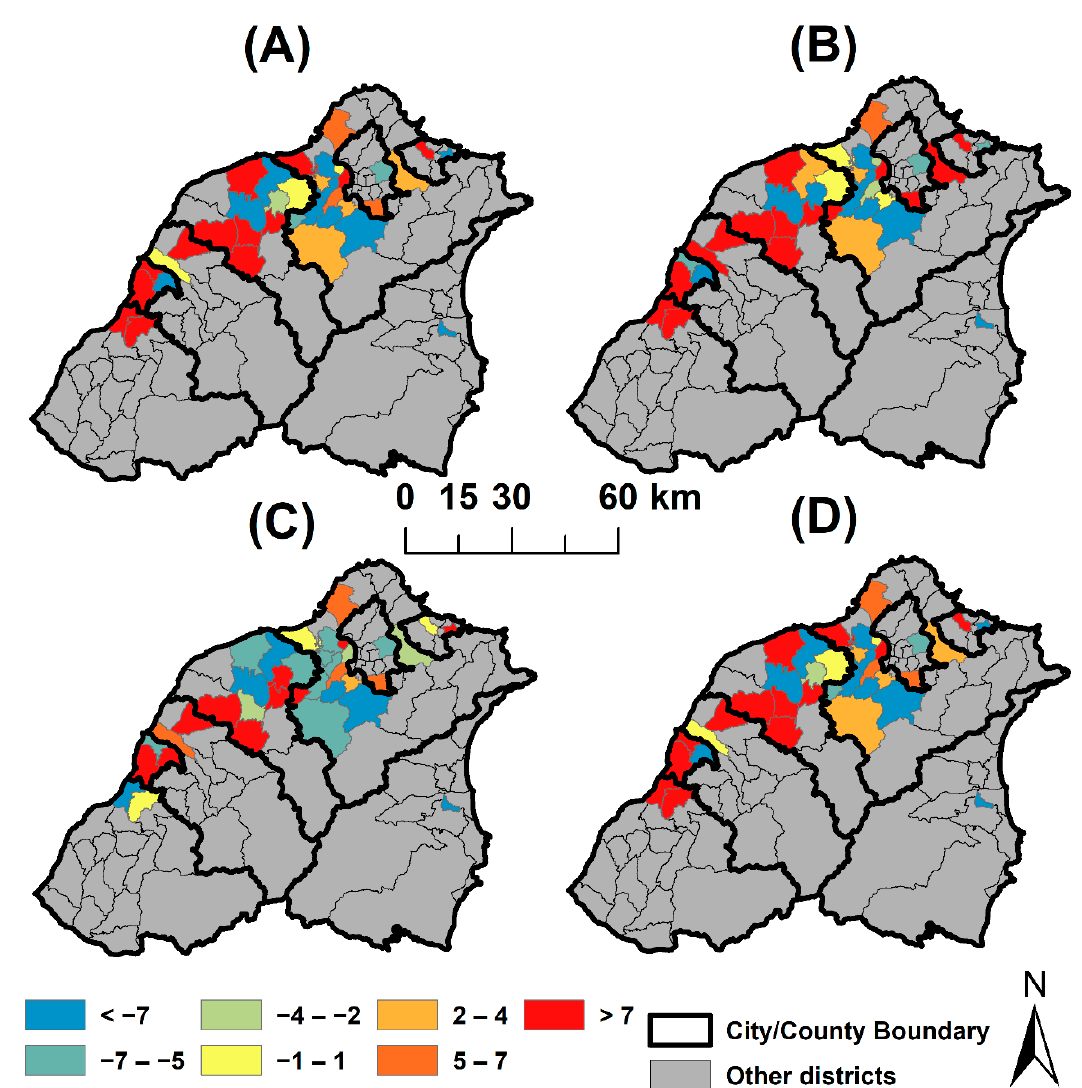
Figure 6. Maps depicting time lag (in years) between population growth and land use expansion by district. ( A ) Residential land use; ( B ) Employment land use; ( C ) Transportation corridor; and ( D ) General Urban (the sum of three land use types). Positive signs of time lags indicate that population growth occurred later than land use expansion, while the negative signs indicate that population growth occurred earlier than land use expansion.